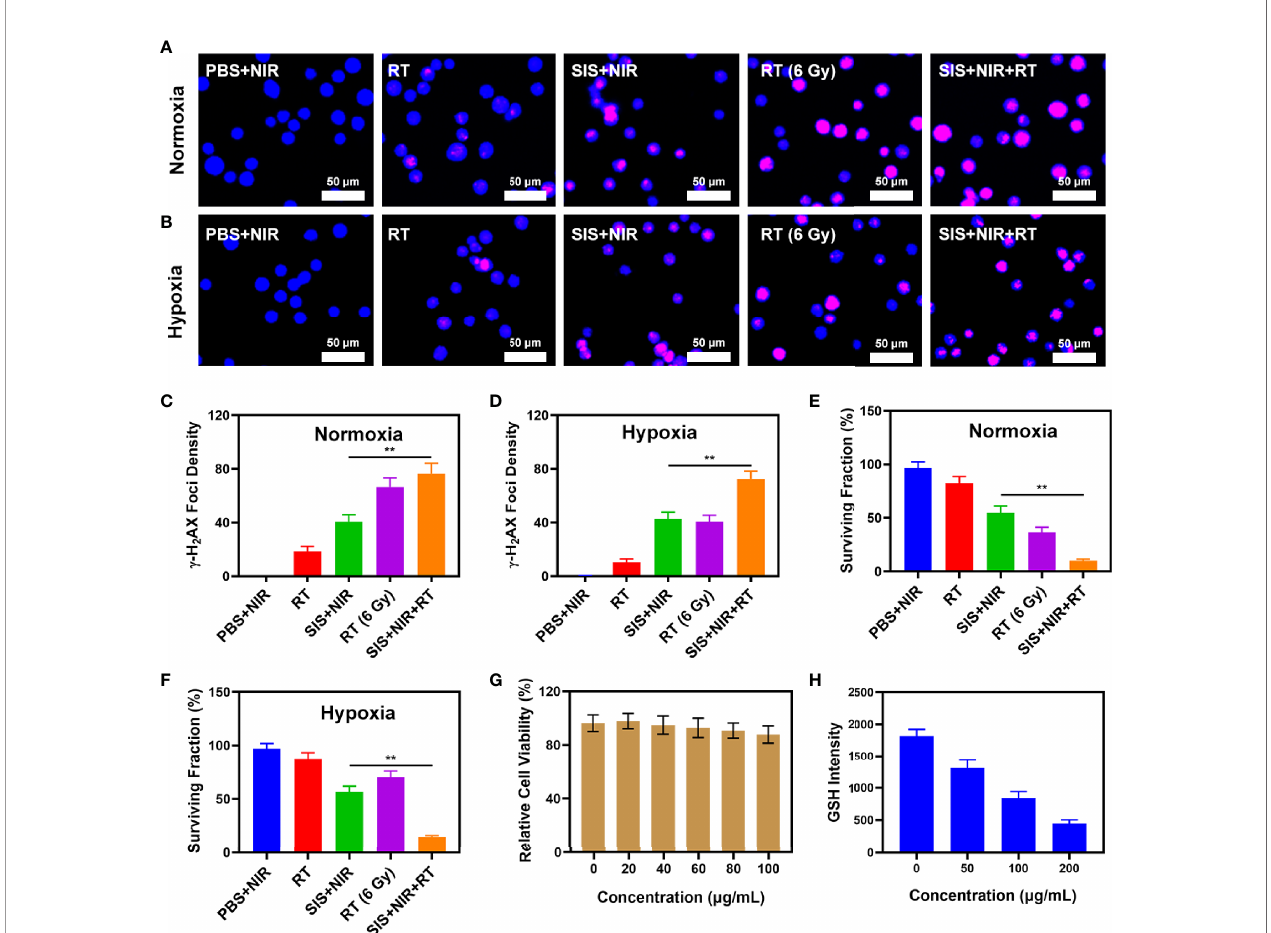
FIGURE 2 | (A) The CLSM images of 4T1 cells under different treatment in normoxia condition. The nuclei were stained with DAPI (blue) and DSBs were stained with g -H 2 AX (red). (B) The CLSM images of 4T1 cells under different treatment in hypoxia condition. The nuclei were stained with DAPI (blue) and DSBs were stained with g -H 2 AX (red). (C) The density of g -H 2 AX foci in (A) was determined based on analyses of 100 cells per treatment group ( g -H 2 AX foci/100 m m 2 , n = 3). (D) The density of g